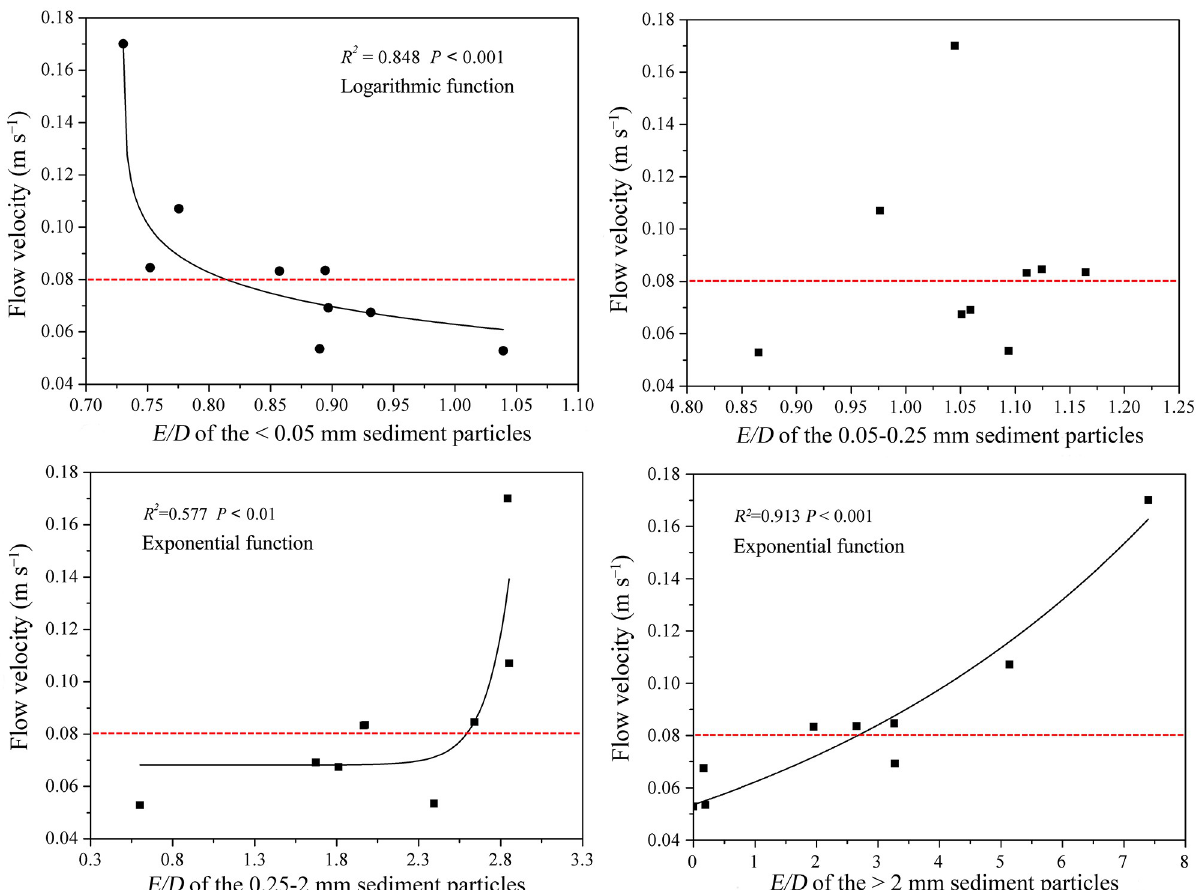
Fig 3. Relationships of flow velocities and effective/dispersed ( E/D ) particle size distribution.